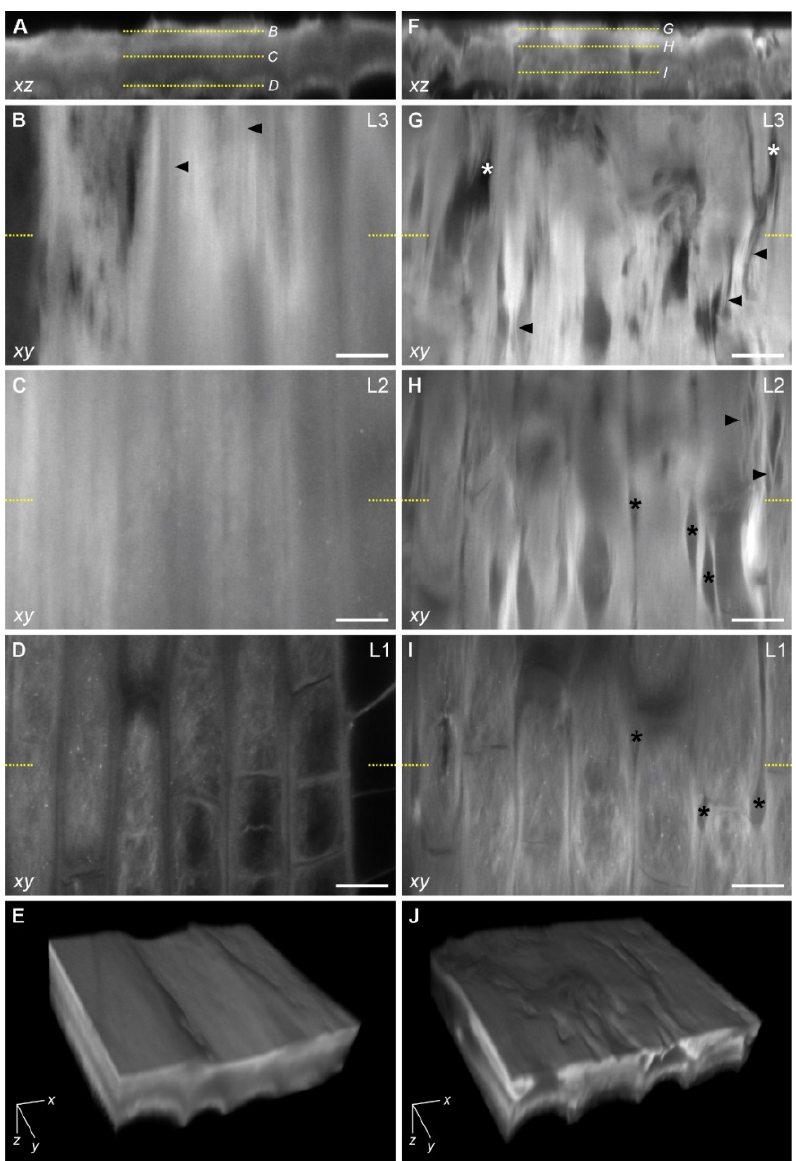
Figure 8. Confocal laser scanning microscope images of the epidermal surface of a representative control root ( A – E ) and stressed root ( F – J ). ( A , F ) Orthogonal projections ( xz ) of z-stacks; yellow dotted lines indicate levels of single optical sections ( xy ) through the L3, L2, L1 presented in ( B – D ) and ( G – I ). Arrowheads in ( B , G , H ) point to fibrillar structures, and asterisks in ( G – I ) show microgaps in the epidermal surface. Short yellow lines in ( B – D ) and ( G – I ) refer to the exact plane of the projections shown in ( A ) and ( F ), respectively. ( E , J ) 3D reconstructions of the L1, L2, L3 in C root ( E ) and S root ( J ) with clearly distinguishable features of the root surface: smooth in ( E ) and furrowed in ( J ). Scale bars: 10 µ